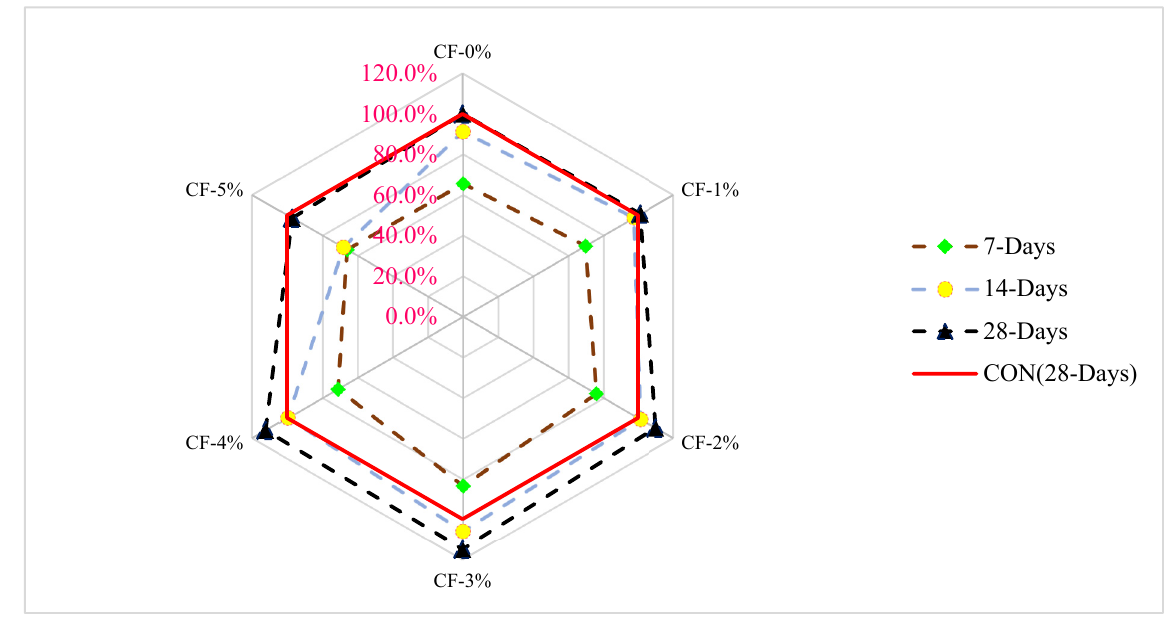
Figure 7. Relative analysis of tensile strength [24].